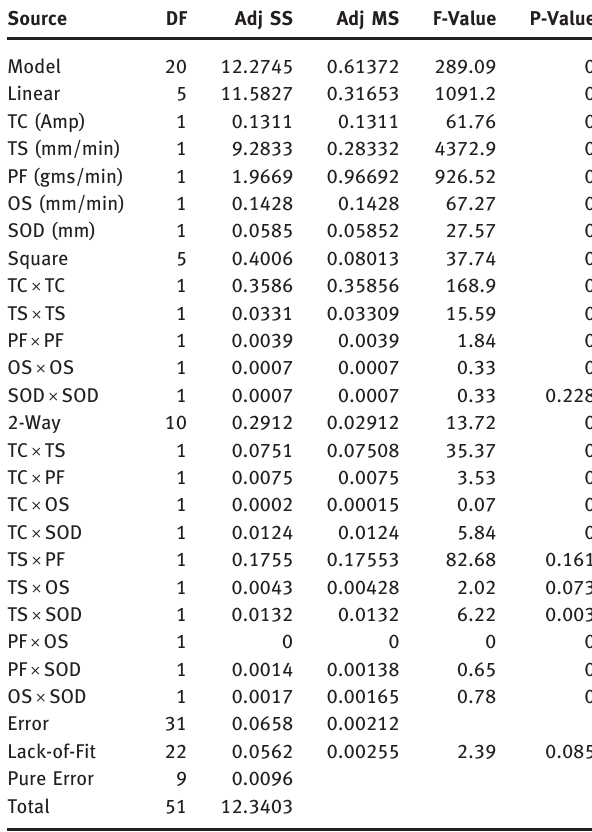
Table 4: Analysis of variance for width of deposition. Source DF